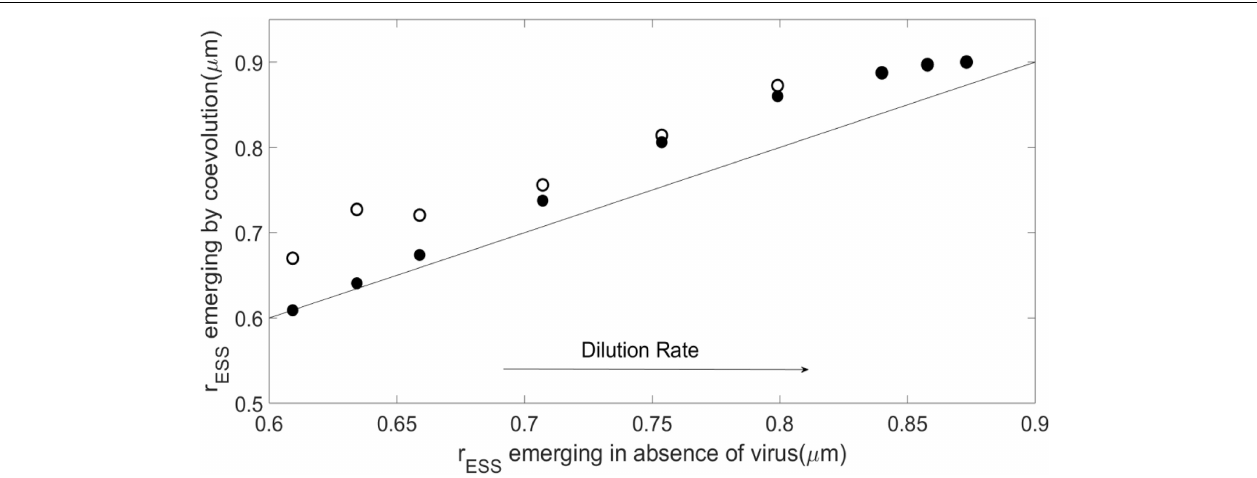
FIGURE 4 | Evolutionary stable strategies (ESS) for the host obtained when it coevolves with the virus as compared with the host ESS in the absence of the virus for N the non-plastic case, all above or on the 1:1 line.